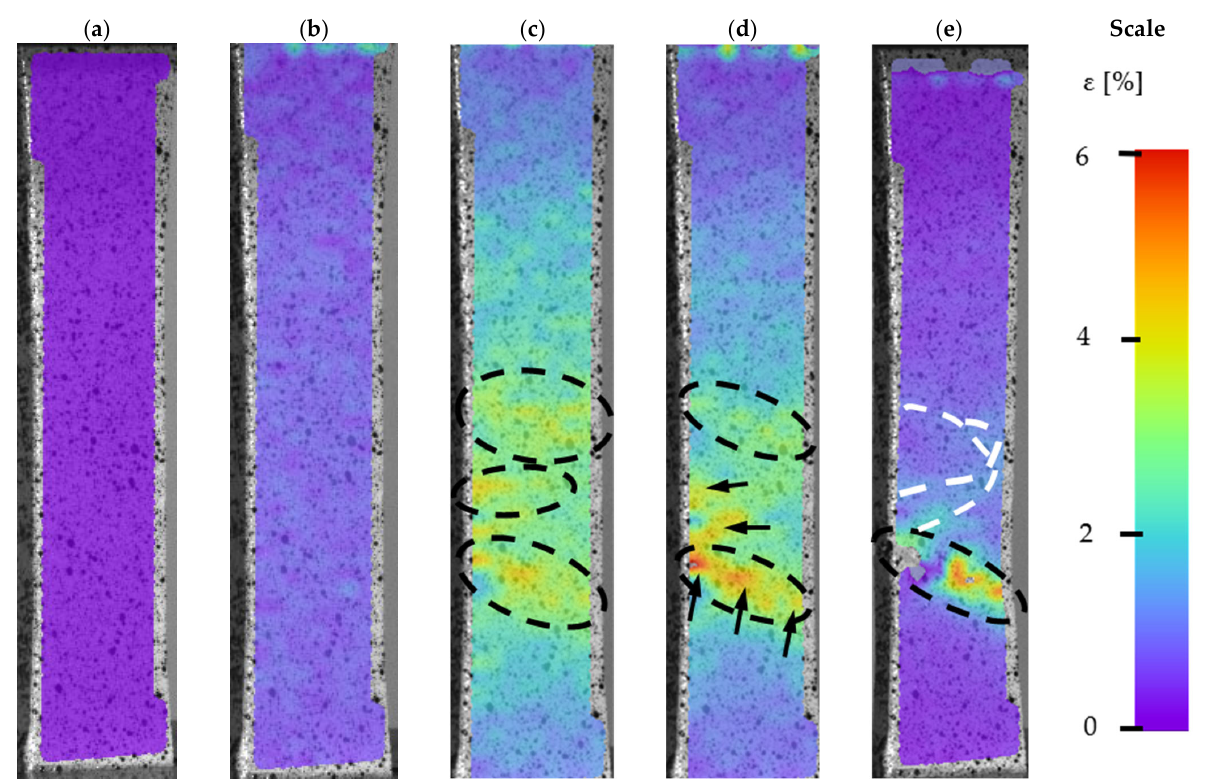
Figure 10. DIC of M300 steel in BHT condition during tensile testing, ( a ) a reference sample before the tensile testing, ( b ) Rp 0.2% proof strength, ( c ) the ultimate tensile strength (UTS) point, ( d ) breaking point, and ( e ) a sample after a fracture.